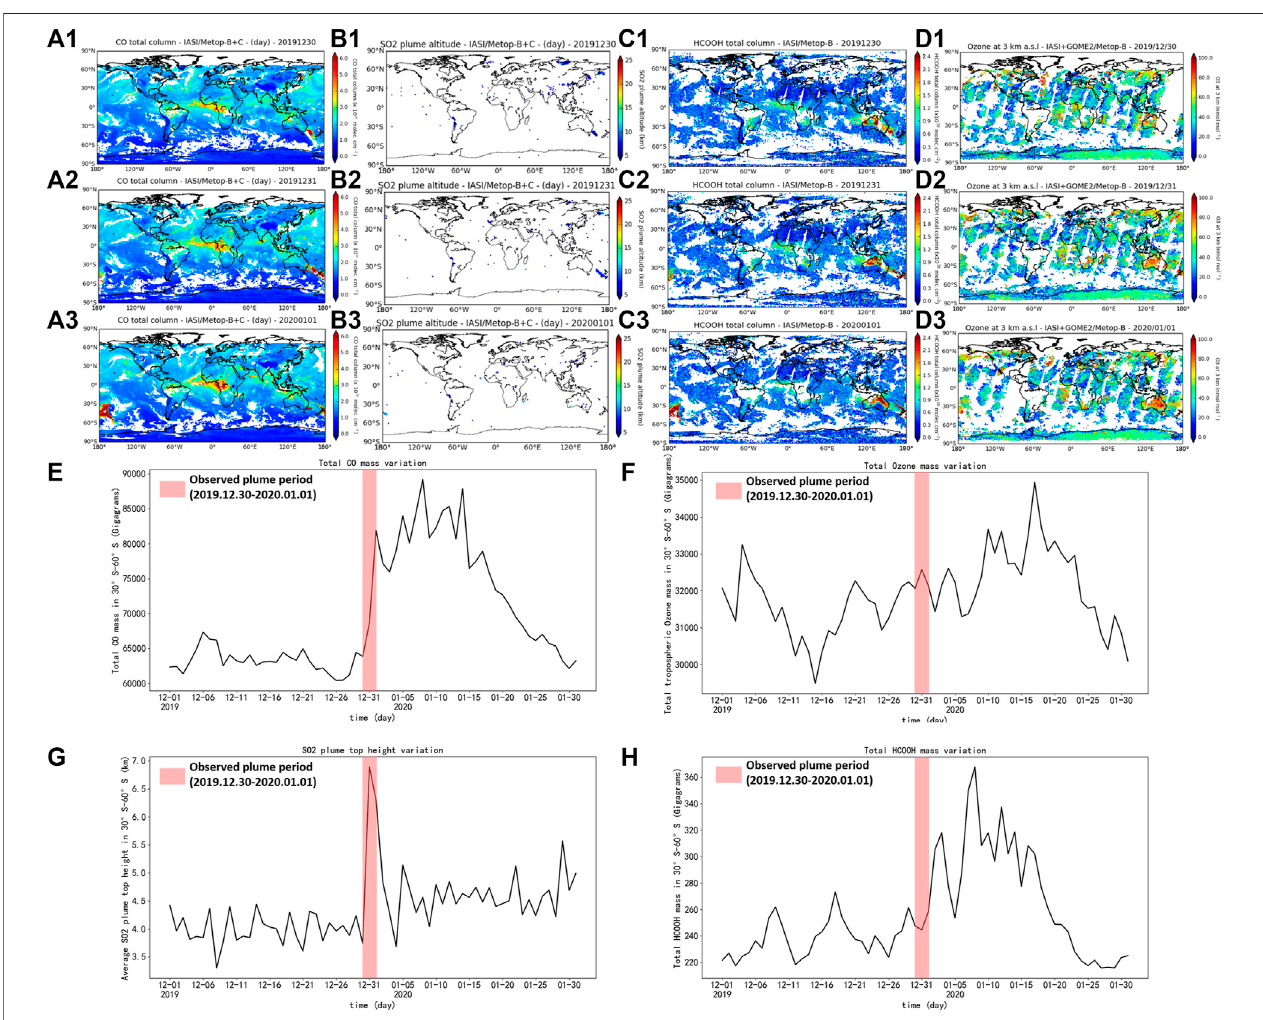
FIGURE7| Globaldistributionof (A1 – A3) theTCofCO, (B1 – B3) SO2plumealtitude (C1 – C3) theTCofFAand (D1 – D3) theTCofozoneat3 kminthemostactive bush fi reperiod(December30 – January1).Variationin (E) totalCOmass, (F) totalozonemass, (G) averageSO2plumetopheightand (H) totalFAmassat30 ° – 60 ° Sfrom November to